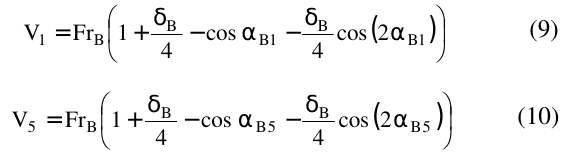
Fig. 6. Modified theoretical Atkinson work cycle in